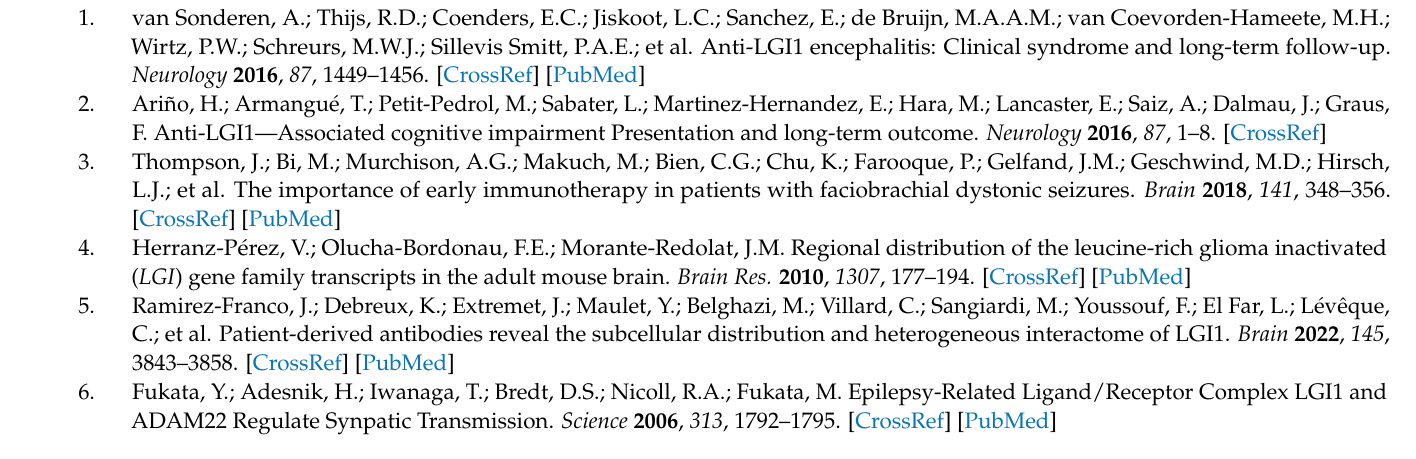
Figure S2: Quantified spine density after short and long ab application of patient LE#2 in CA3. Figure S3: Representative images of anti-Caspase3 staining in hippocampal